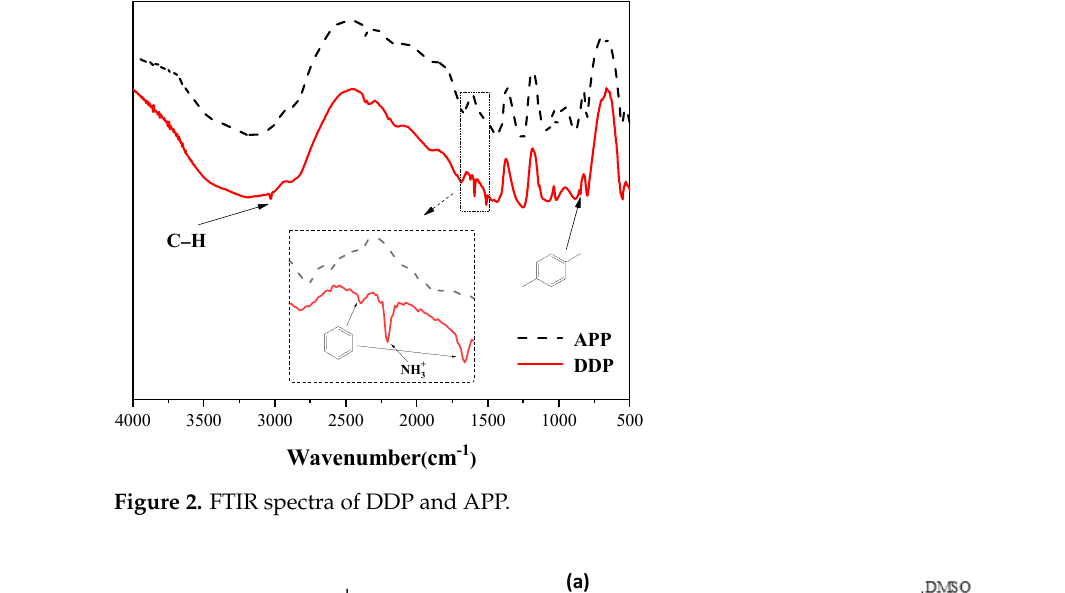
Figure 2. FTIR spectra of DDP and APP .